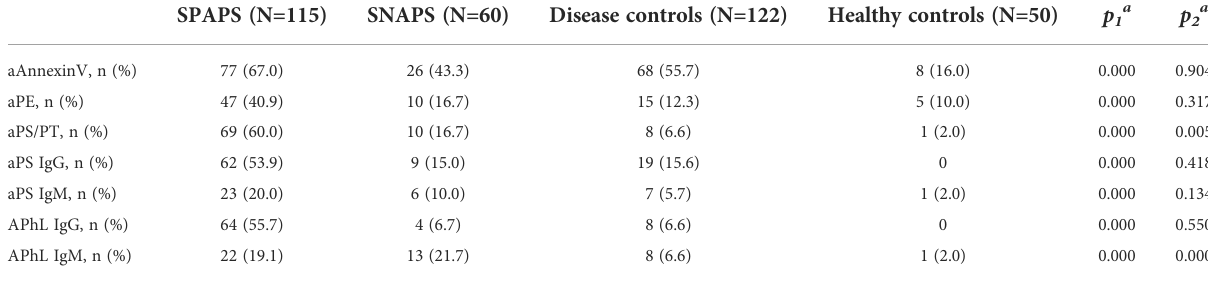
TABLE 2 Prevalence of non-criteria antibodies.